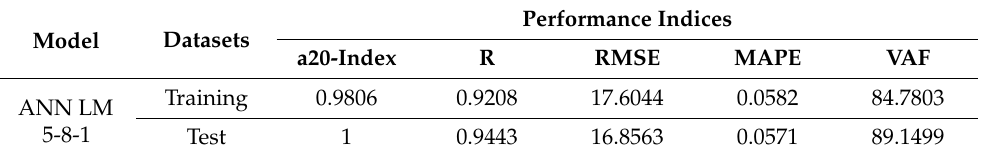
Table 7. Summary of prediction capability of the optimum ANN LM 5-8-1